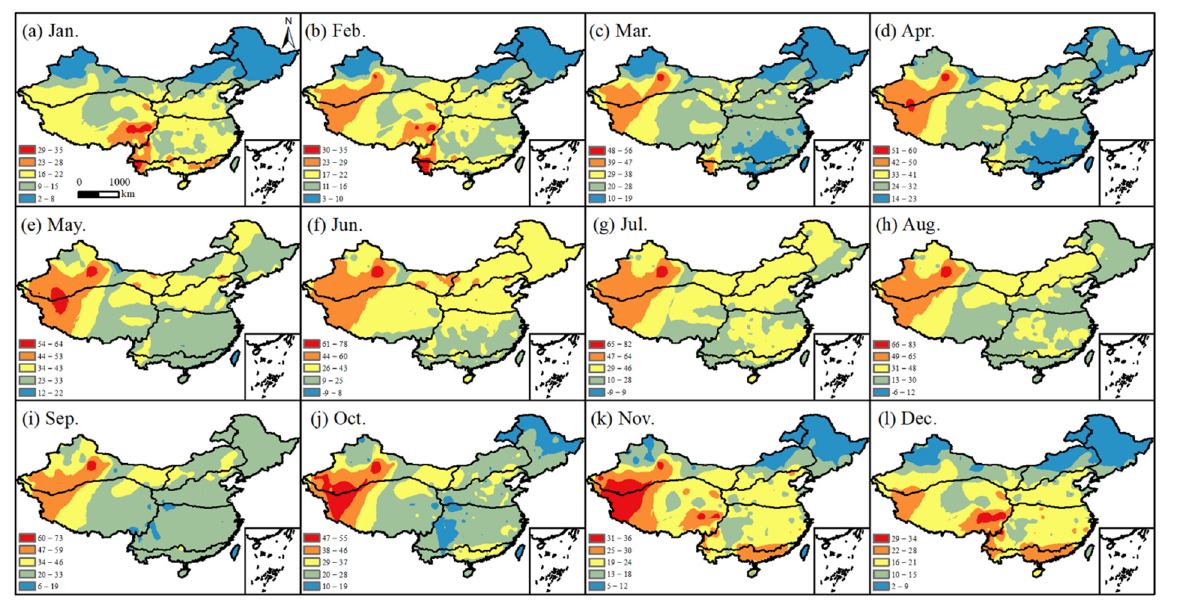
Figure 6. The spatial distribution of the long-term mean monthly D in mainland China (the site values were interpolated by the Kriging method in ArcGIS 10.3).